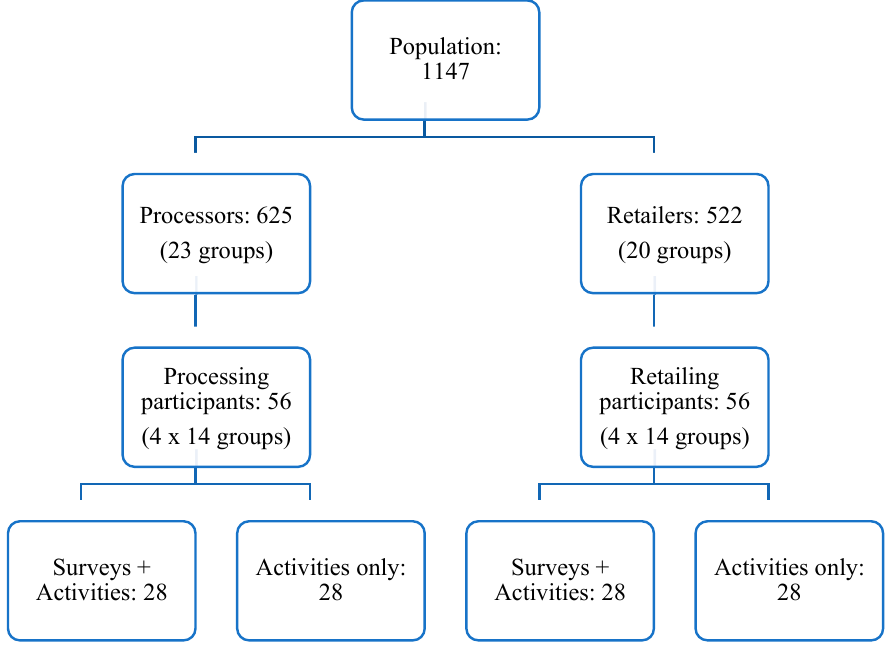
Figure 2. Sampling